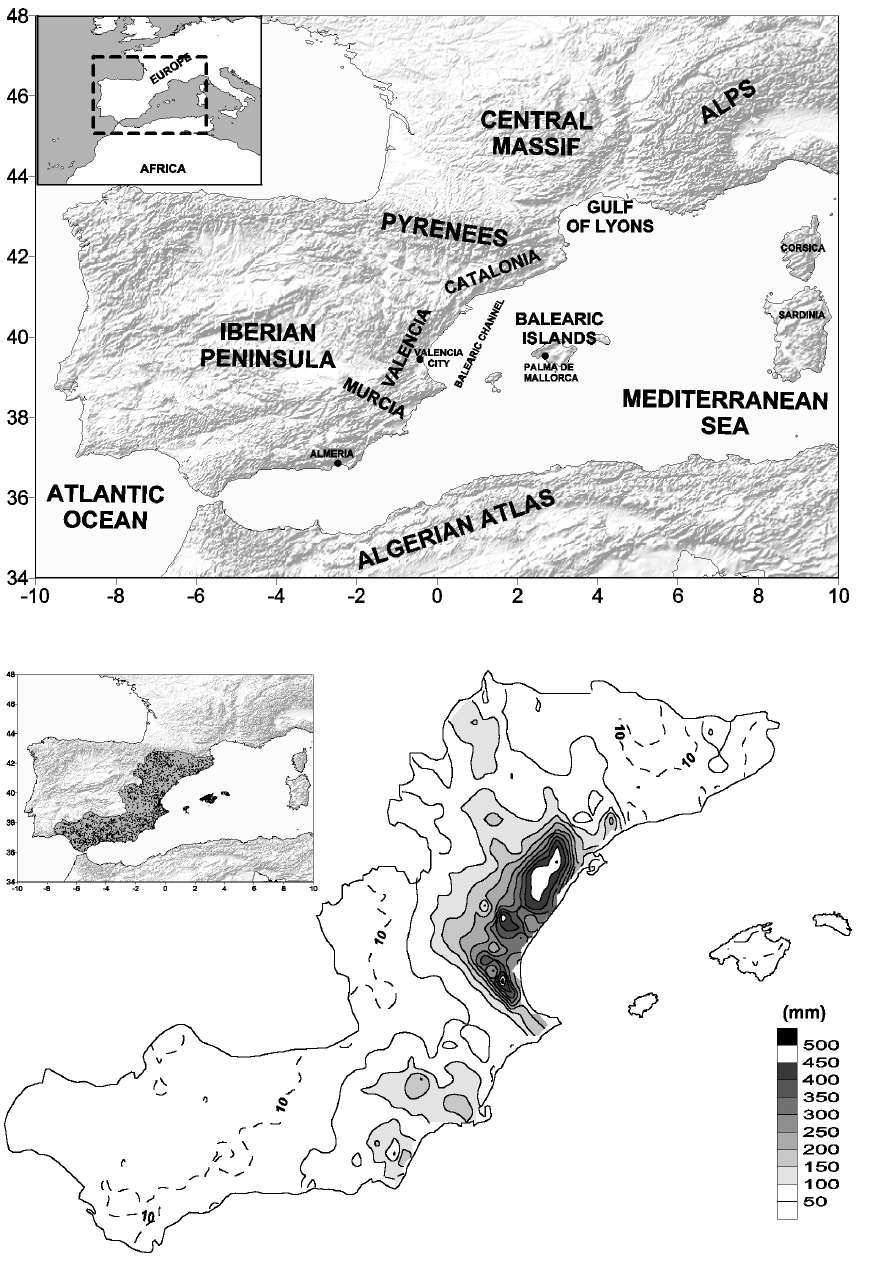
rain-gage precipitation (mm). The top left corner map indicates the area and the location (dots) of the 1967 stations used to perform the